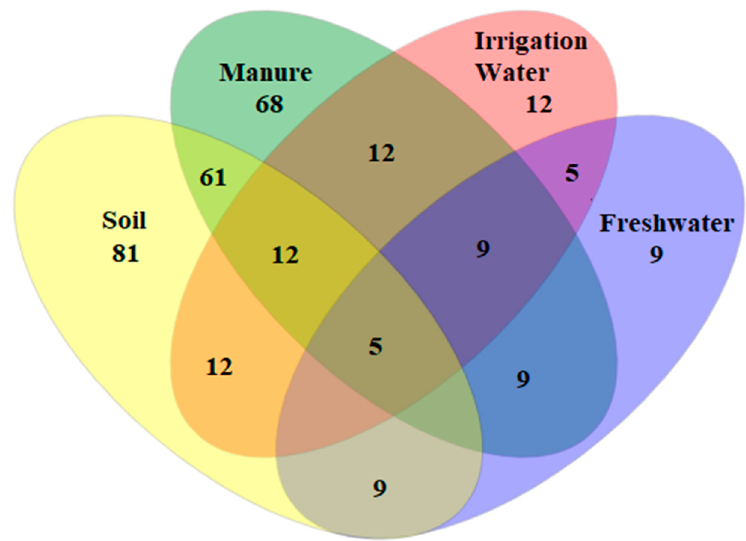
Figure 5. A Venn diagram depicts the overlap (or shared) ESBL-producing Salmonella spp. serovars in a multidimensional network between soil, manure, irrigation water and freshwater matrices. The number inside overlapping ellipses denotes shared